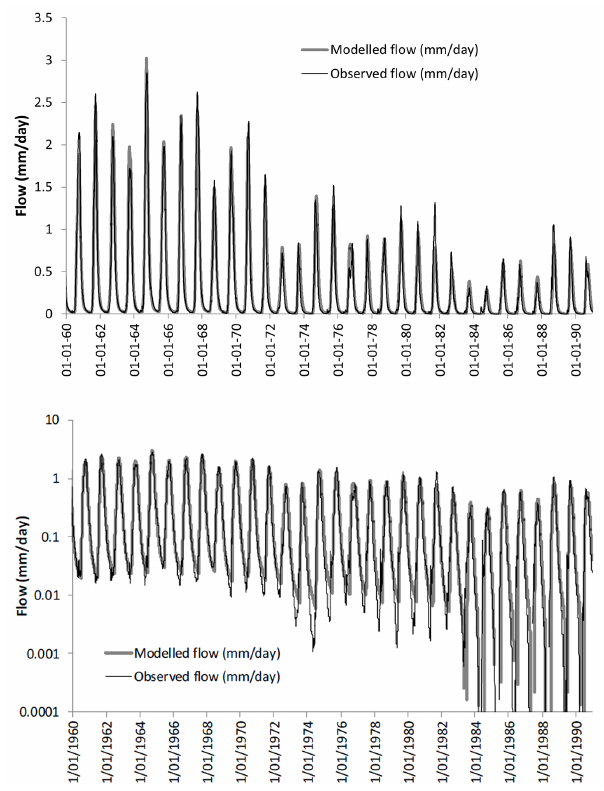
Figure 4. Comparison of modelled flows generated by modified model with the observed flows for the Bani